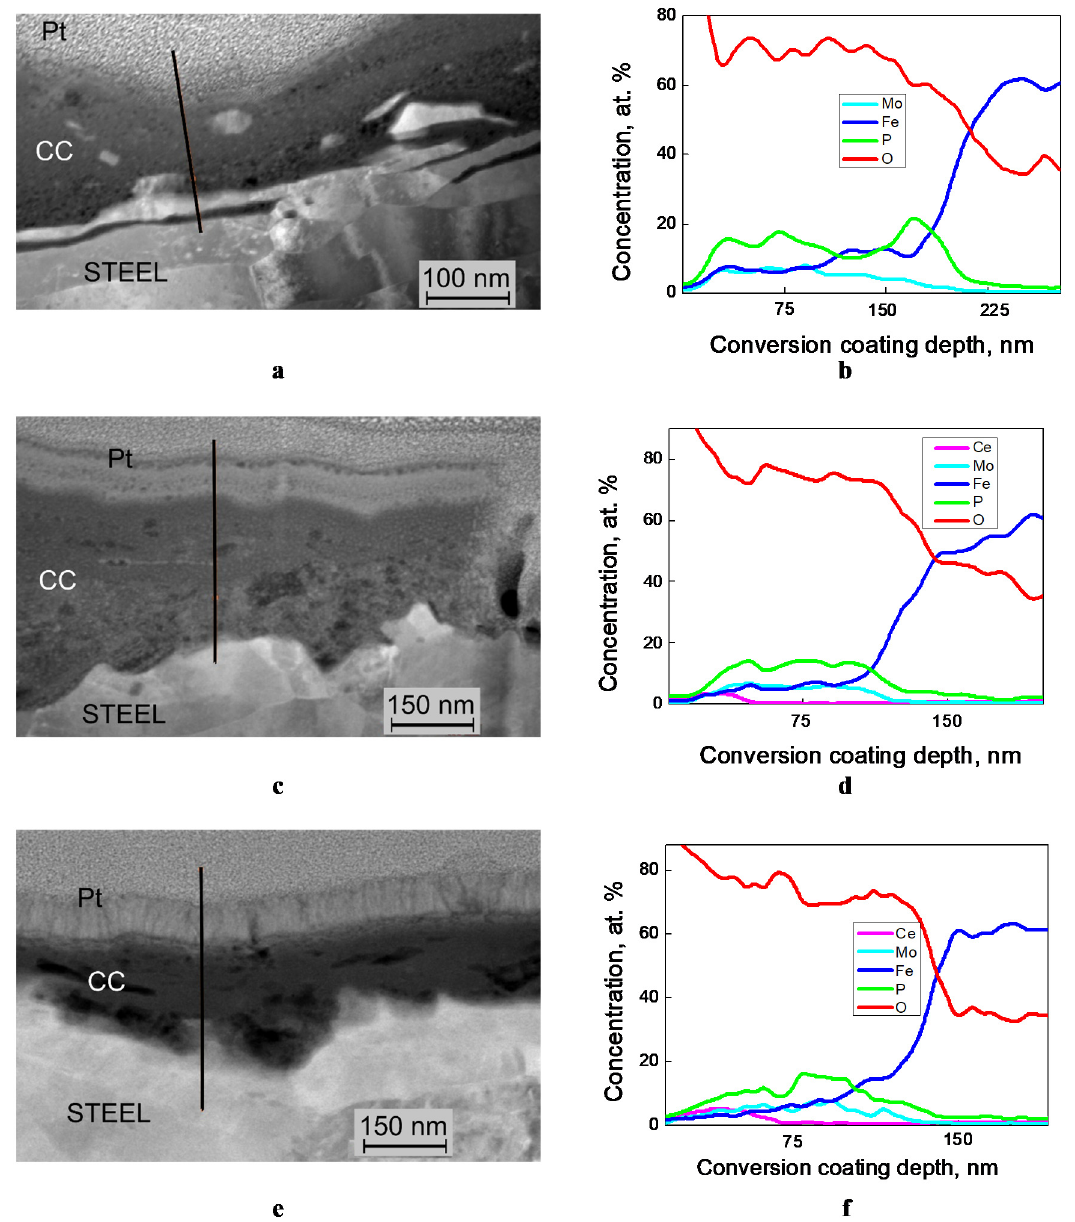
Figure 3. Cross-sectional TEM images ( a , c , e ) and element concentration profiles ( b , d , f ) of Fe/P-Mo ( a , b ), Fe/P-Mo-Ce1 ( c , d ) and Fe/Mo-Ce2 ( e , f ) conversion coatings.